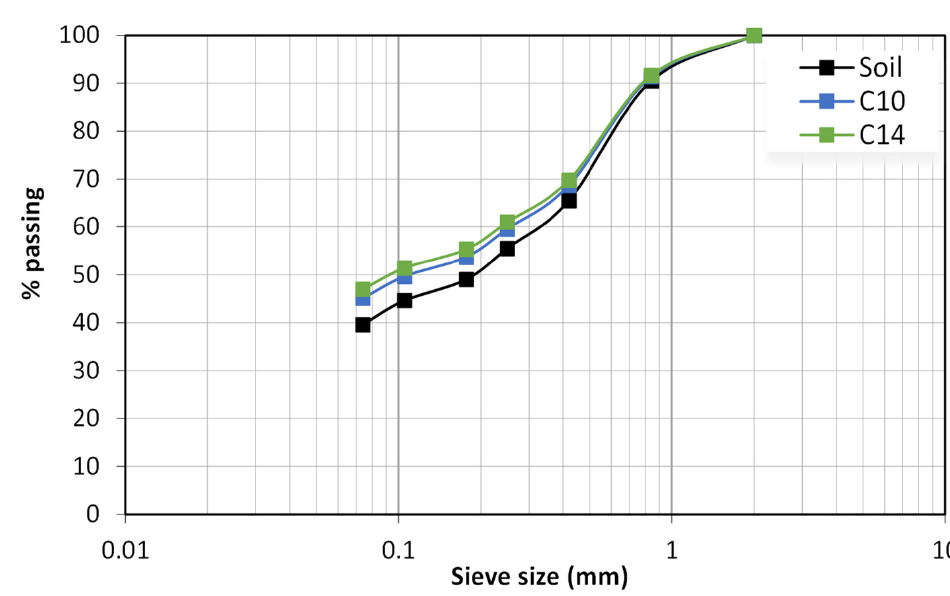
Figure 5. Particle size distribution of CBS mixtures.